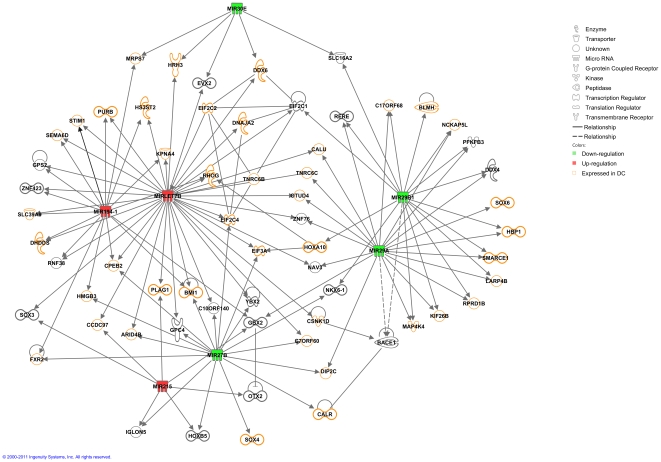
Significant gene network of porcine miRNA predicted targets.Putative gene targets and relationships defined by porcine miRNAs differentially expressed in infected and mock-infected DCs. For miRNAs over-expressed in mock-infected samples molecule symbols are coloured in green and for miRNAs over-expressed in infected samples molecule symbols are coloured in red. For genes known to be expressed in DCs, the molecule symbols are represented with yellow borders. Relationships between miRNAs and genes are defined based on IPKB.